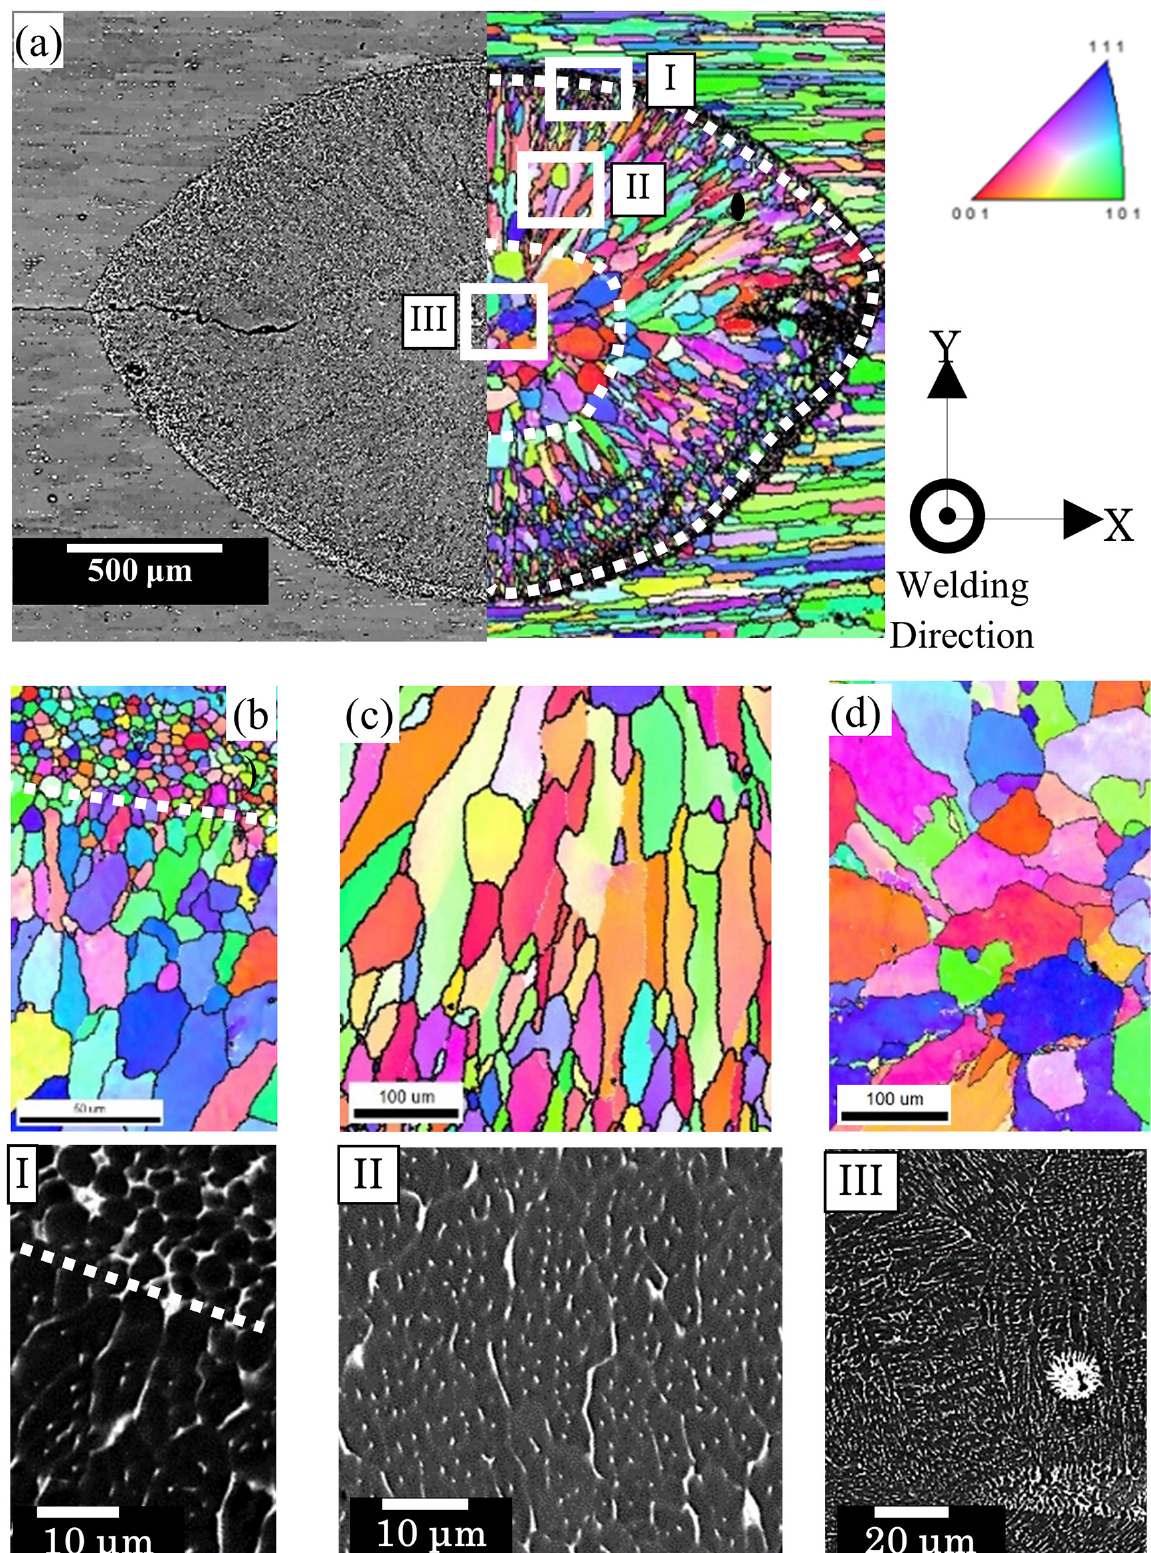
Figure 5: (a) Combined image of backscatter electron (BSE) image (Left) and orientation EBSD map (Right) of the fusion zone; (b) EBSD map of the chill zone (area I); (c) EBSD map of the columnar zone (area II) and (d) EBSD map of the equiaxed zone (area